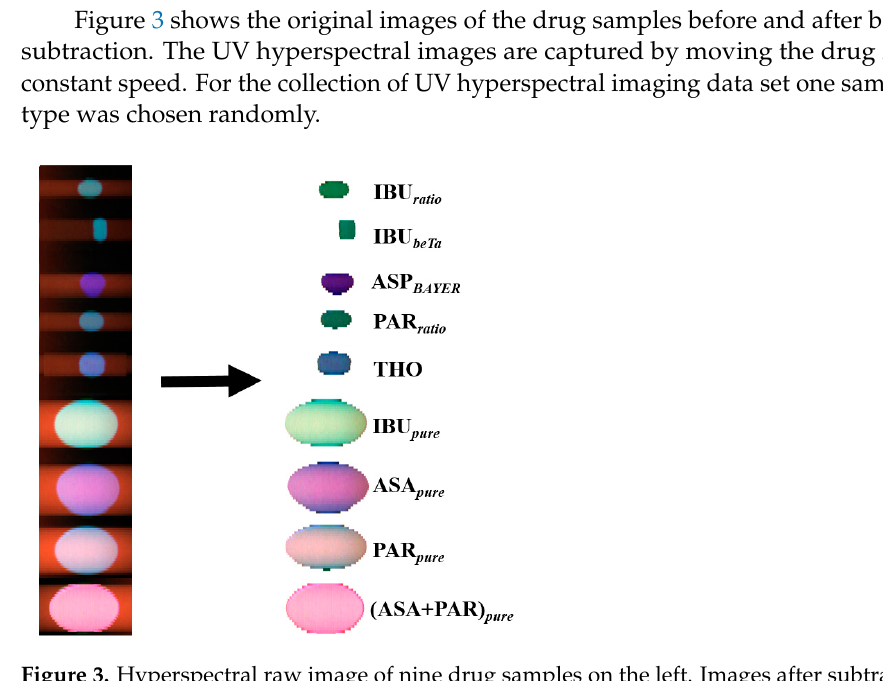
Figure 3. Hyperspectral raw image of nine drug samples on the left. Images after subtraction of the background on the right.